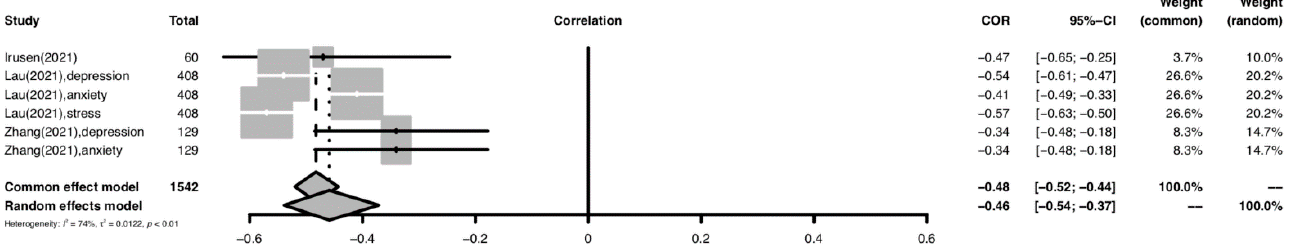
Figure 4. Forest plot of the relationship between resilience and psychological distress among patients Abbreviation: COR, correlation coefficient; CI, confidence interval; I 2 , indicator of statistical heterogeneity; p , p -value; τ 2 , indicator of statistical heterogeneity. Horizontal lines indicate the 95% CI of each study; diamonds indicate the pooled estimate with a 95% CI.